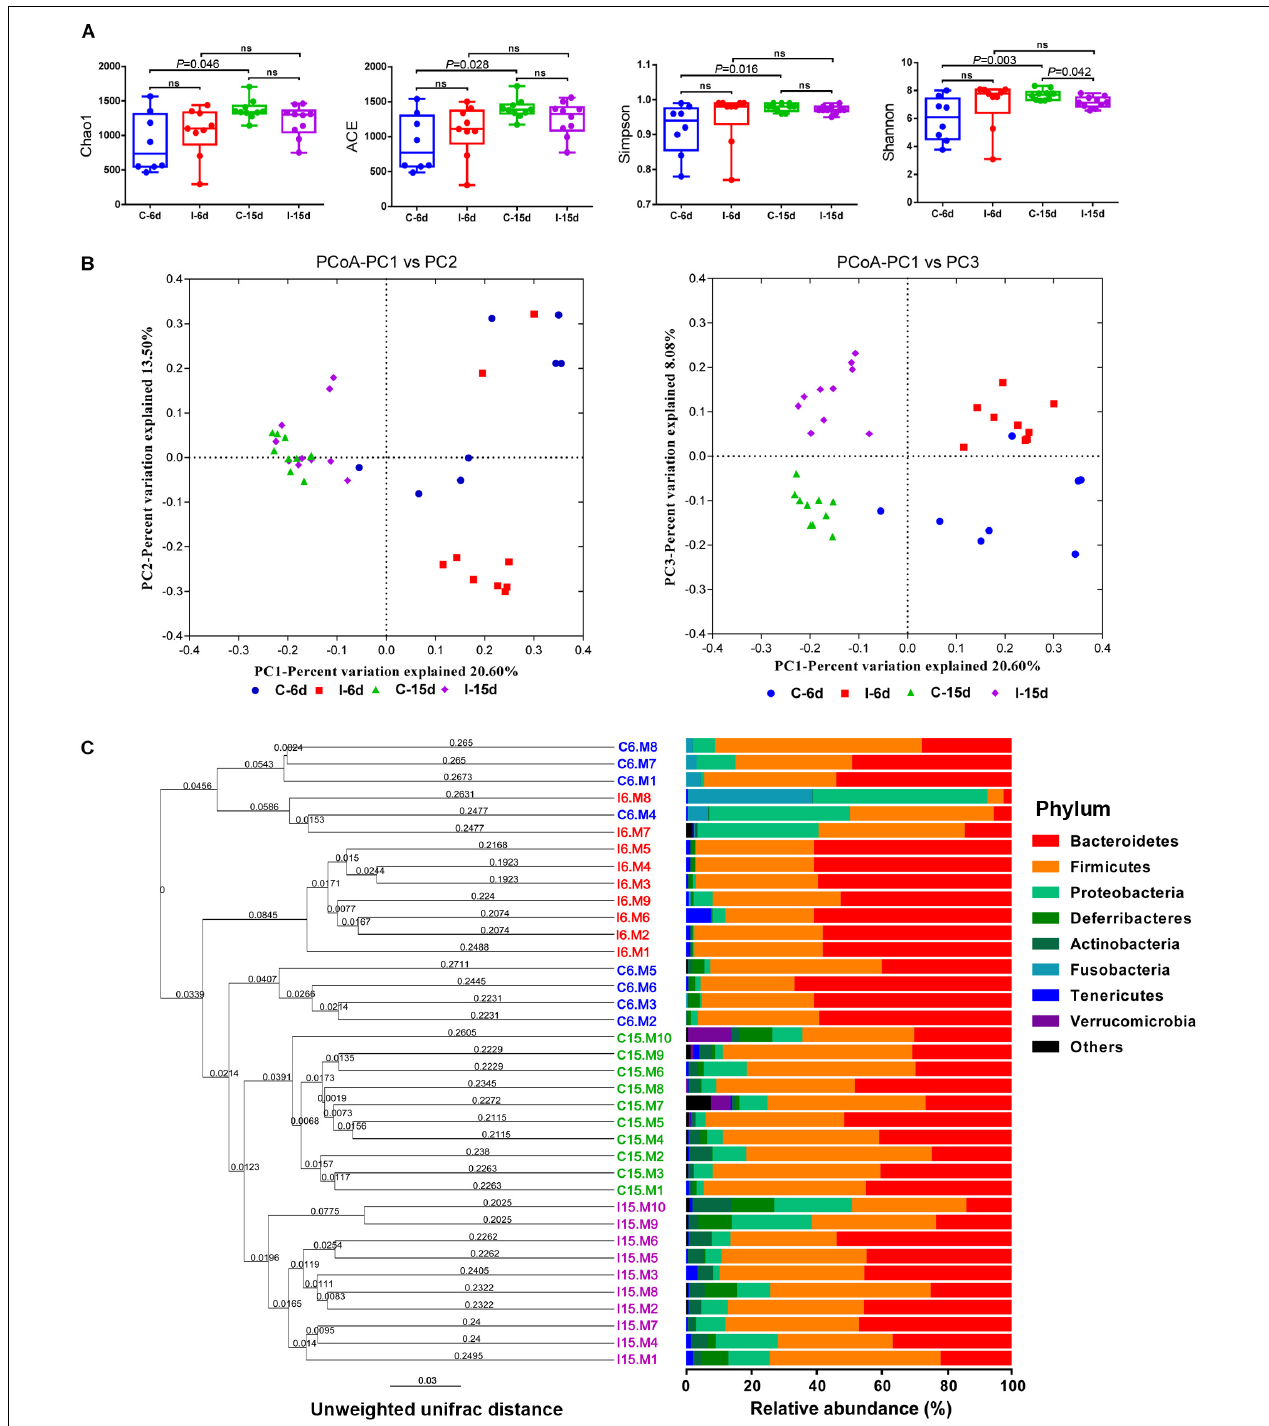
FIGURE 1 | D-GPV infection reduced the microbial diversity and altered the structure of community in the ceca. (A) Richness and diversity within caecal microbial from uninfected and D-GPV infected ducks. Values are shown as min to max with the mean value calculated for each groups. Statistical tests were performed using post hoc ANOVA and ns indicated no significant difference. (B) Principal coordinate analysis of unweighted UniFrac distances. Samples are colored by different group— Blue, Control-6 days (C-6d, n = 8); Red, D-GPV infection-6 days (I-6d, n = 9); Green, Control-15 days (C-15d, n = 10); Purple, D-GPV infection-15 days (I-15d, n = 10). Axes are scaled by the percent of variation explained by each principal coordinate. (C) Cluster analysis based on unweighted unifrac distance UPGMA. In order to examine the global differences in bacterial composition between the D-GPV infected ducks and the controls over time, we calculated distances between each sample using the unweighted Unifrac. Samples are colored by different group same as (B) .